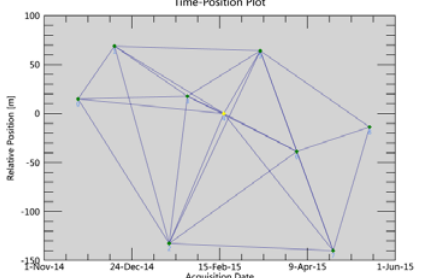
Figure 1. Spatial-temporal baselines of the generated interferograms. Points represent SAR images and numbered lines are the interfereometric pairs.